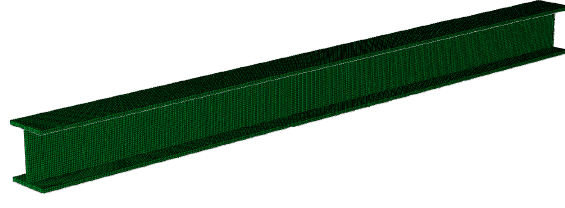
Figure 10. Finite element model of sound specimen.